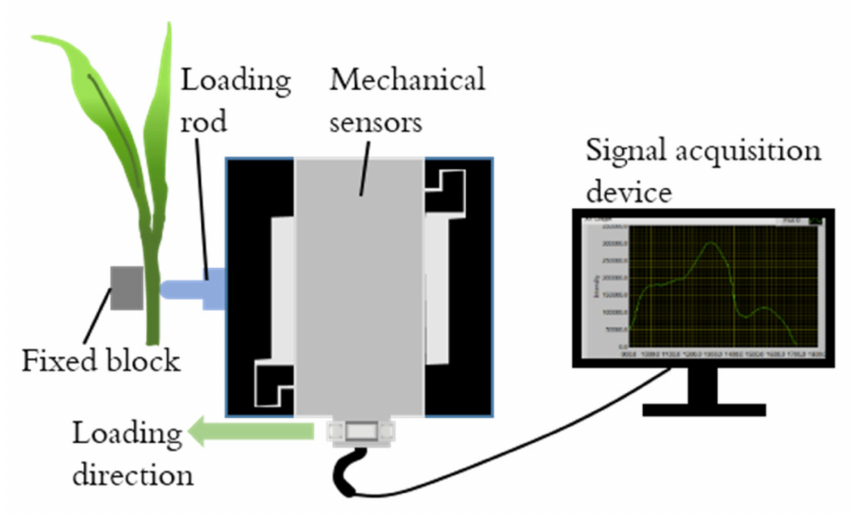
Figure 3. Setup of the mechanical